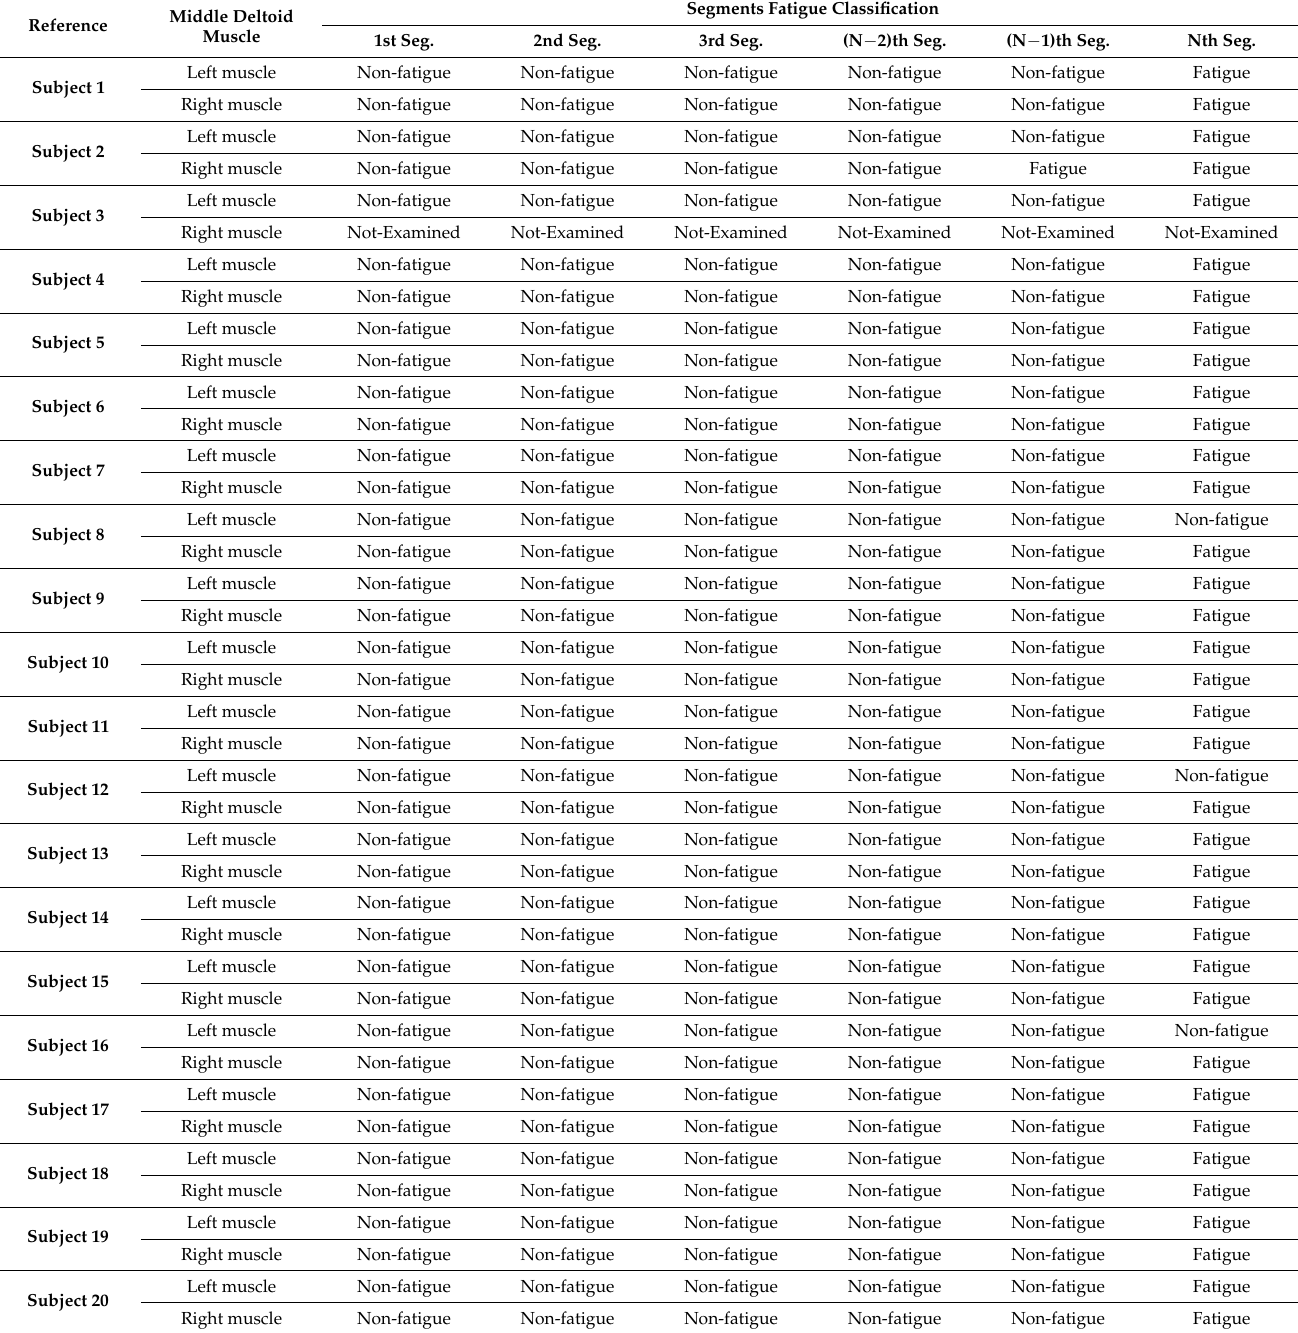
Table 6. Accuracy of the proposed